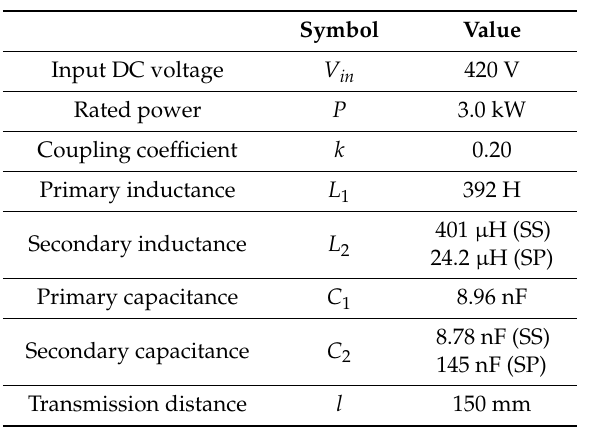
Table 1. Specifications of prototype.